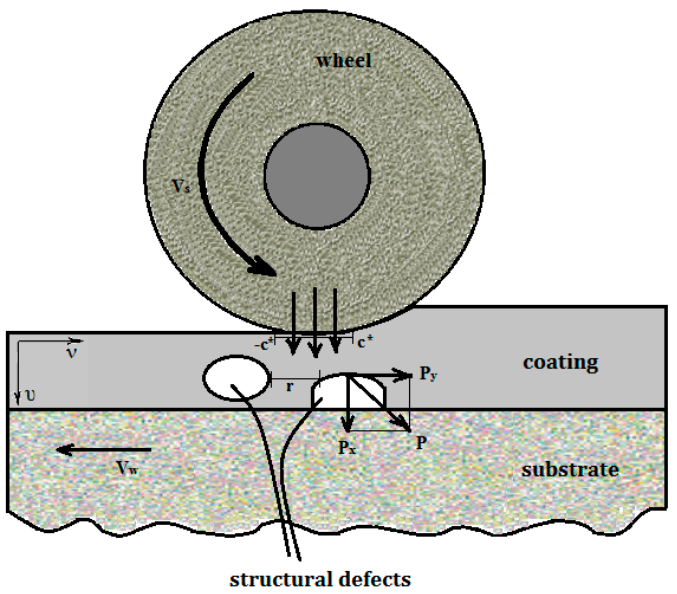
Figure 1. Schematic of material removal in surface grinding.